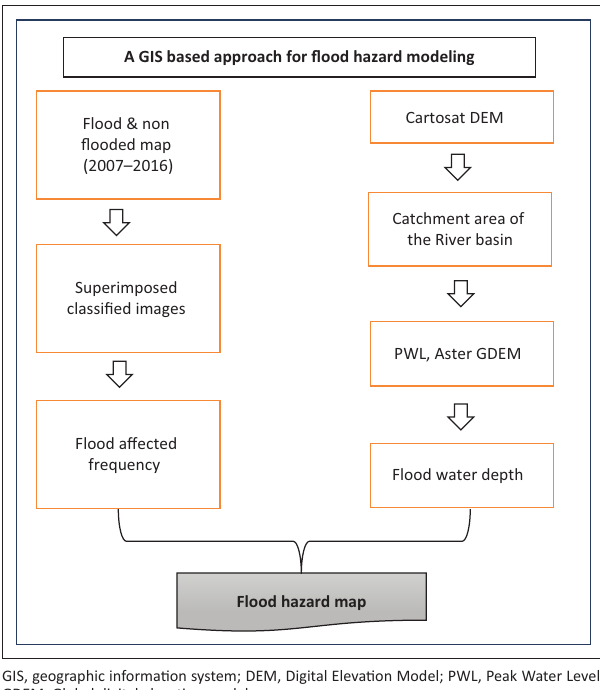
FIGURE 3: A geographic information system-based computational protocol for flood hazard